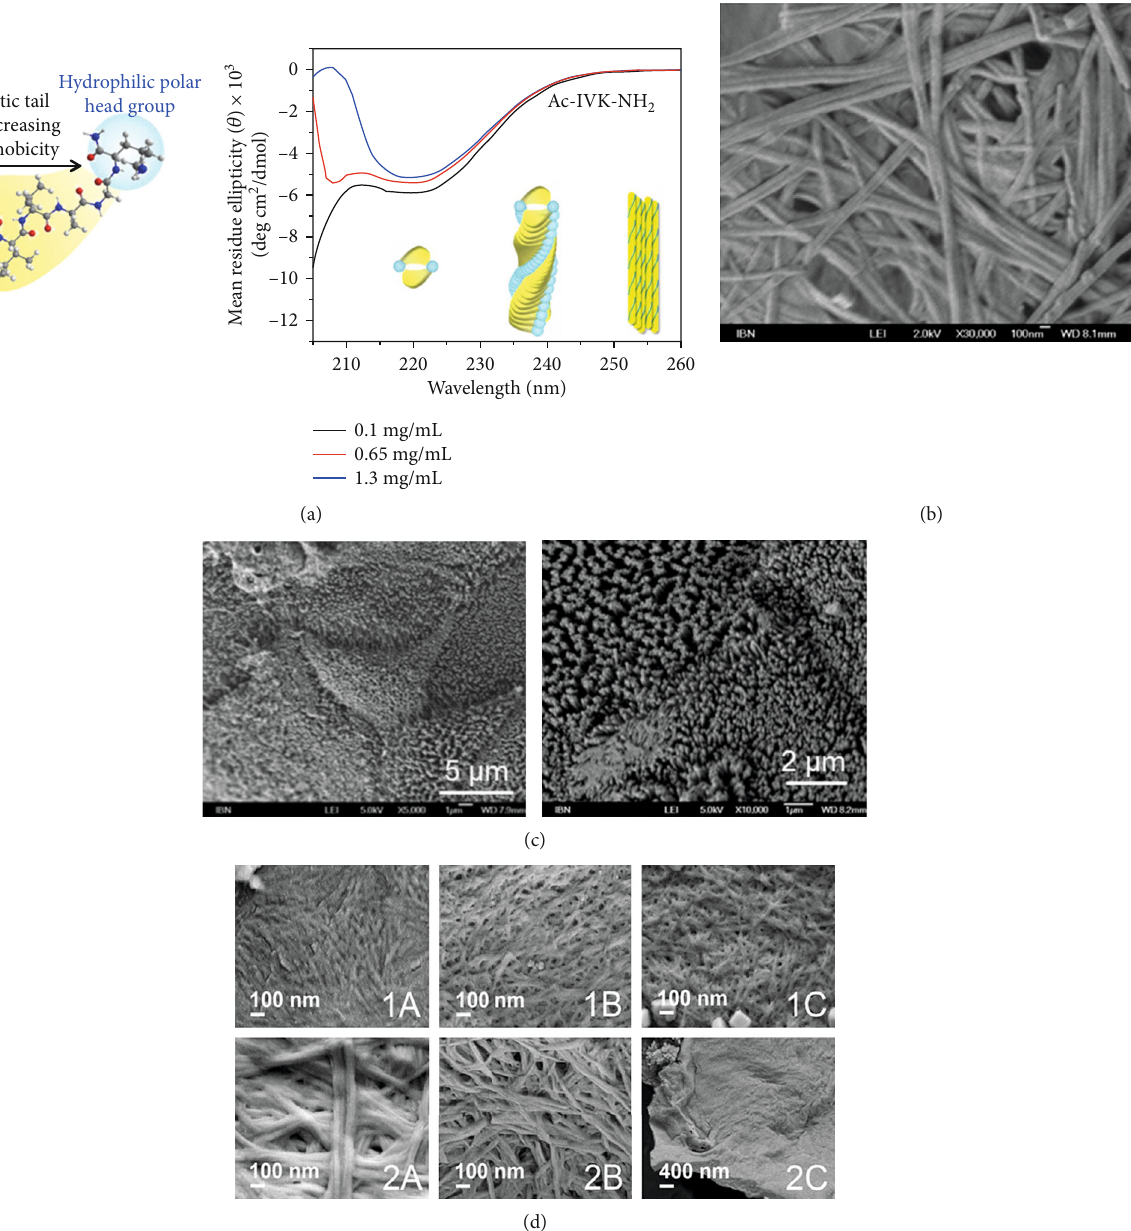
Figure 3: (a) Mechanism of assembly of aliphatic SAPs. Due to the hydrophobicity gradient in the peptide monomer, the monomers will assemble fi rst in antiparallel pairs. Next, dimers will form intermediate α -helical structures. The nano fi ber will be formed when multimers stack into stable β - fi brils. (b) Field emission scanning microscopy (FESEM) of the interconnected nano fi ber structures. (c) Field emission scanning microscopy (FESEM) of Caco2 intestinal epithelial cells cultured on an SAP hydrogel. Homogeneous microvilli phenotype can be observed. (d) Topography of trimers and pentamers with di ff erent C-terminus residues. The diameter and prevalence of the individual fi bers depend on the properties of the changing residue. These fi gures have been reproduced with permission from the American Chemical Society and Springer Nature [66,